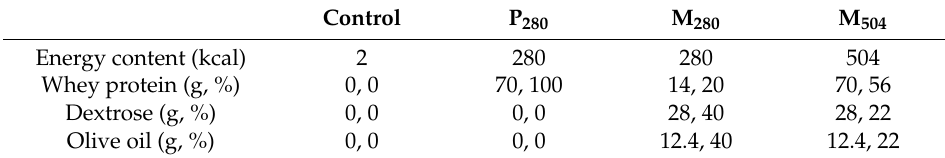
Table 1. Energy content and composition of liquid supplements used in study